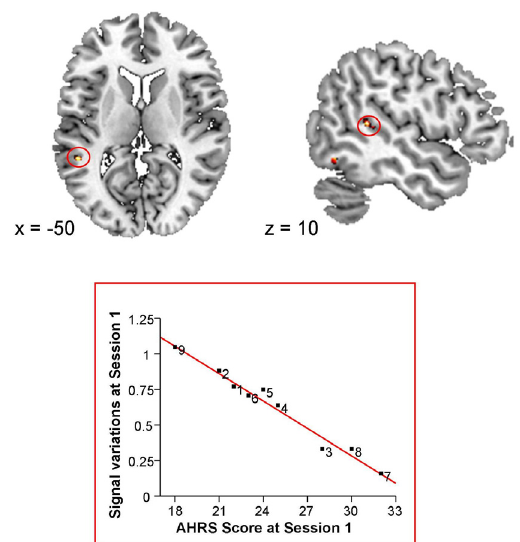
Upper row: Results of the negative correlation between BOLD signal variations and AHRS scores at baseline in schizophrenia patients ( p < 0.001 uncorrected, k > 14 voxels). Results are superimposed on a sagittal ( x = − 50) and axial ( z = 10) slice of the single-subject Montreal Neurological Institute template. Bottom row: negative correlation between baseline mean signal variations in the significant cluster and AHRS scores at session 1. The numbers indexing patients are the same across all